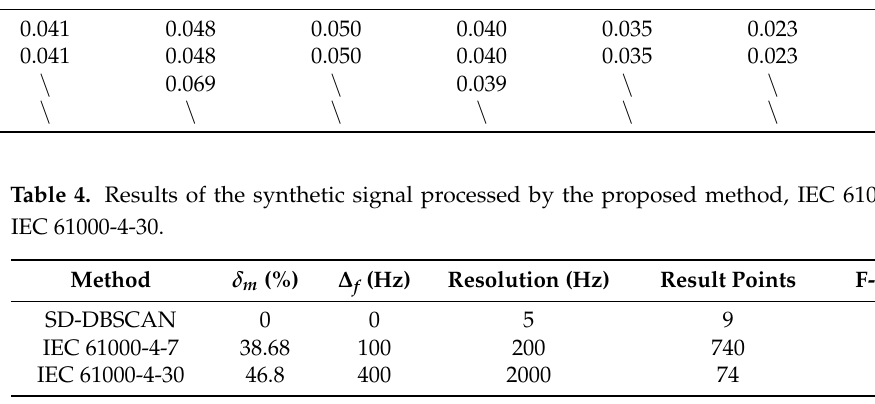
Figure 6. The synthetic signal was analyzed by the proposed method, IEC 61000-4-7 (method A) and IEC 61000-4-30 (method B) in 2–150 kHz. ( a ) The spectrum of detection results and IEC 61000-4-7. ( b ) The spectrum of detection results and IEC 61000-4-30. Table 3. The amplitudes of the synthetic signal measured by the proposed method, IEC 61000-4-7, and IEC 61000-4-30. Method